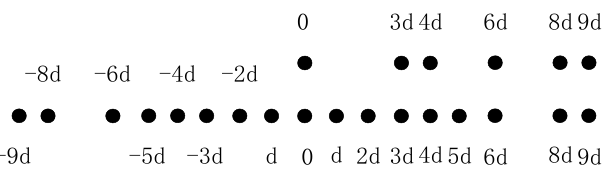
Figure 1. The structure of the coprime array with M = 3, N = 4, and the virtual array constitute. The signal of the virtual array can be obtained using the received signal of the actual array element of the coprime array. The array formed by the newly obtained